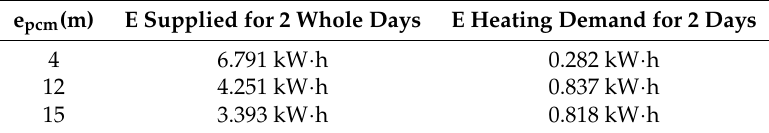
Figure 9. Effect of PCM storage wall thickness on the power released by the solar Trombe wall and temperature inside the bedroom. Table 4. Energy supplied by the solar Trombe wall and energy heating